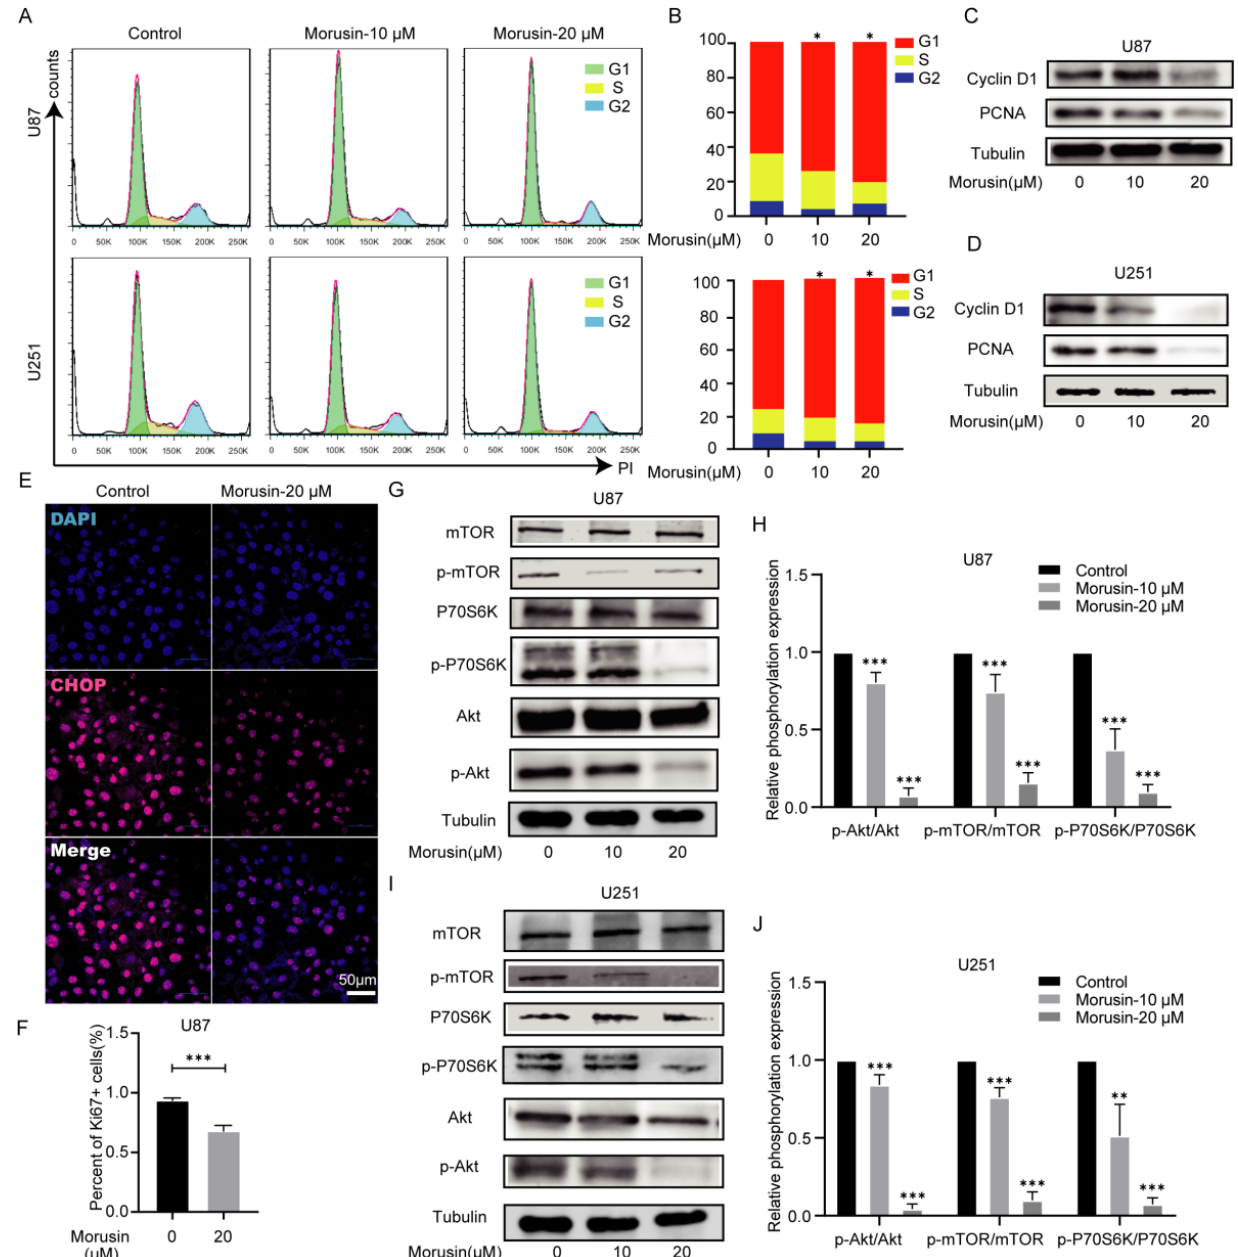
Figure 4. Morusin arrested cell cycle at G1 phase and inhibited cell proliferation through the Akt–mTOR–p70S6K pathway. ( A , B ) Cell-cycle profile of PI-stained cells was analyzed by flow cytometry (morusin treatment for 24 h after cell cycle synchronization). Quantification of cell cycle following PI staining. n = 3. ( C , D ) Protein expression levels of cyclin D1 and PCNA in U87 and U251 after 24 h morusin treatment (0, 10, 20 µM) were measured by Western blot. ( E ) Ki67 (red) was stained by Alexa Fluor 647 in U87 cells treated with morusin (20 µM, 12 h) or vehicle and analyzed by a confocal microscopy. Nuclei were stained with DAPI (blue). bar = 50 µm. ( F ) Quantification of the number of ki67 positive cells. ( G – J )